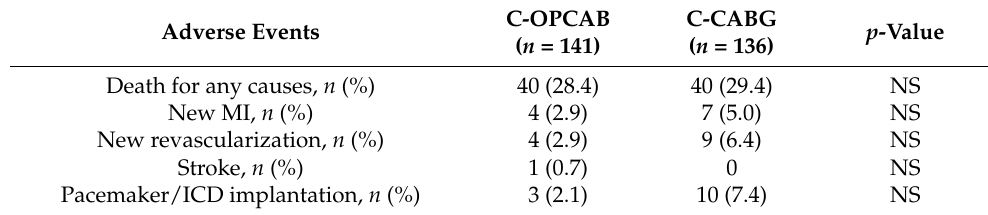
Table 3. Multivariable predictors of long-term survival and cardiac death. Survival Covariates HR 95% CI p -Value Age at operation time (70.3 vs. 65.7 yrs) 4.5 1.041–1.109 <0.0001 Preoperative LVEF (0.50 vs. 0.52) − 2.4 0.940–0.993 0.015 Late cardiac death Covariate Preoperative LVEF (0.49 vs. 0.52) − 4.1 0.887–0.959 <0.0001 LVEF, left ventricular ejection